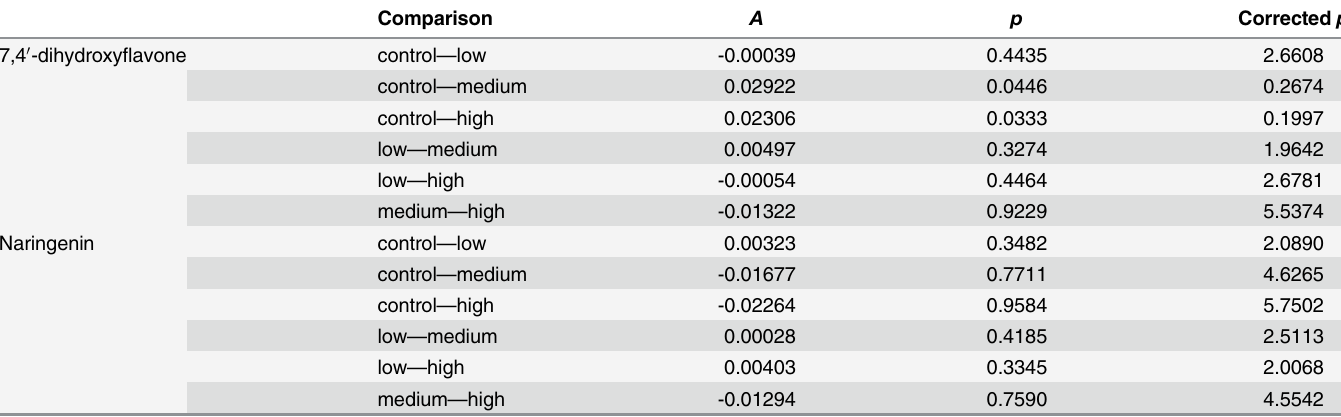
Table 2. Multi-response permutation procedure (MRPP) results.